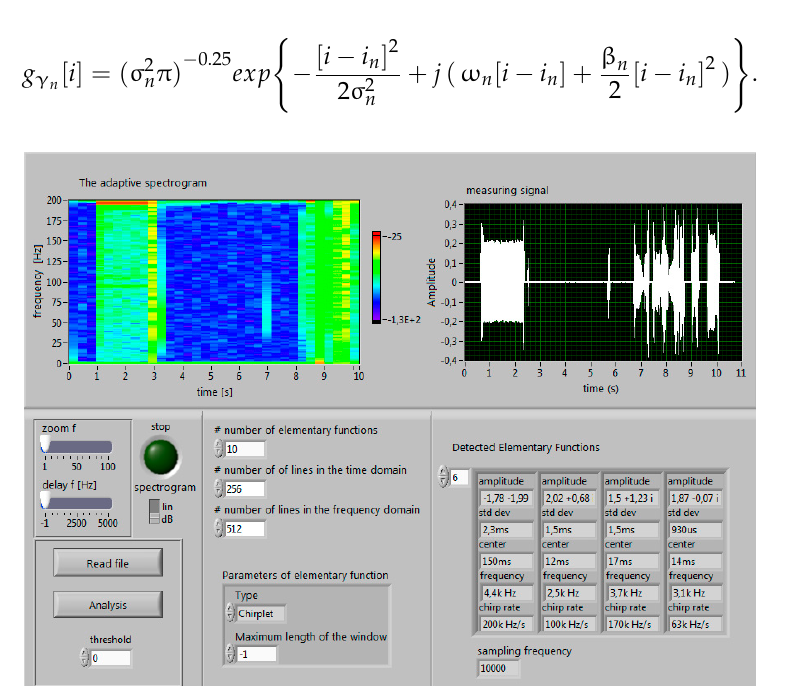
Figure 2. The front panel of the virtual analyzer. It shows the time waveform of the measured signal, its adaptive spectrogram, and information about parameters of the detected chirplets. The measured signal represents the MFD in the surroundings of the ship’s motor drive during manoeuvers [18]. The VI Adaptive transform.vi (Figure 3) is used to decompose an input signal into a linear combination of Gaussian chirplets, described by Equation (4). In Figure 3 the output Chirplet Info contains the parameters of each detected Gaussian chirplet elementary function, indicated in Table 1.